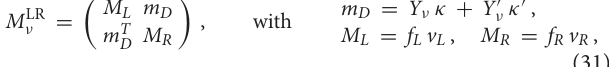
2 jets (no missing energy) at the LHC run 2 ( √ s 14 and L 30fb − 1 ), while the dashed ones define regions + = = e γ ), BR( µ e , Al,Ti) as a function of M R M SUSY . The gray area 3 e ), and CR( µ → → − =